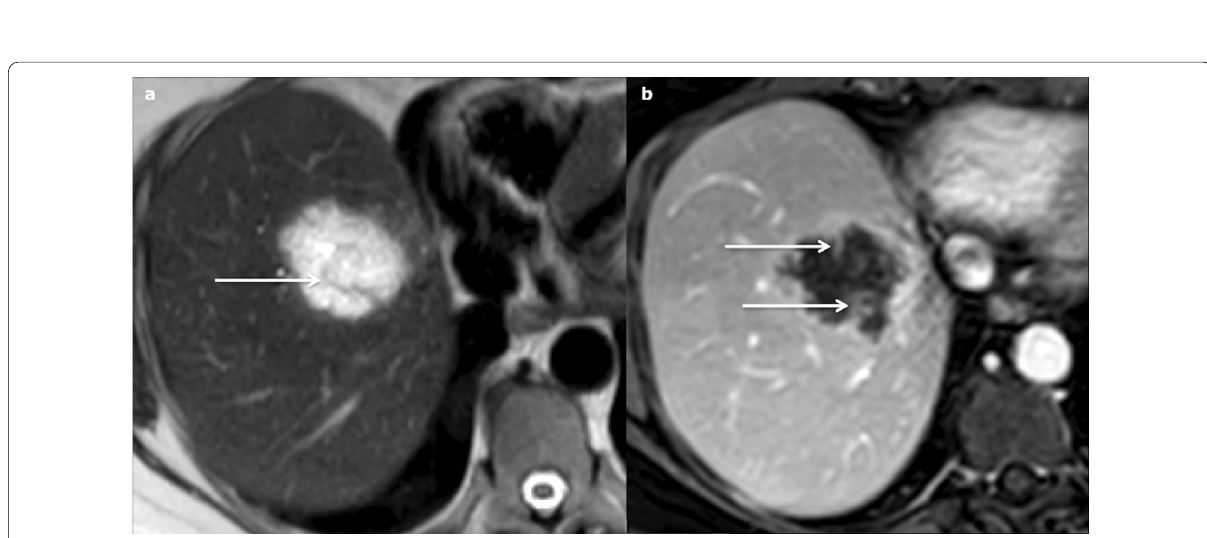
stage. There are no more daughter cysts. It produces both hypoechoic and hyperechoic signal, whose pat- tern resembles a ball of wool [53]. (inactive/degenera- tive stage), is partially or completely calcified.